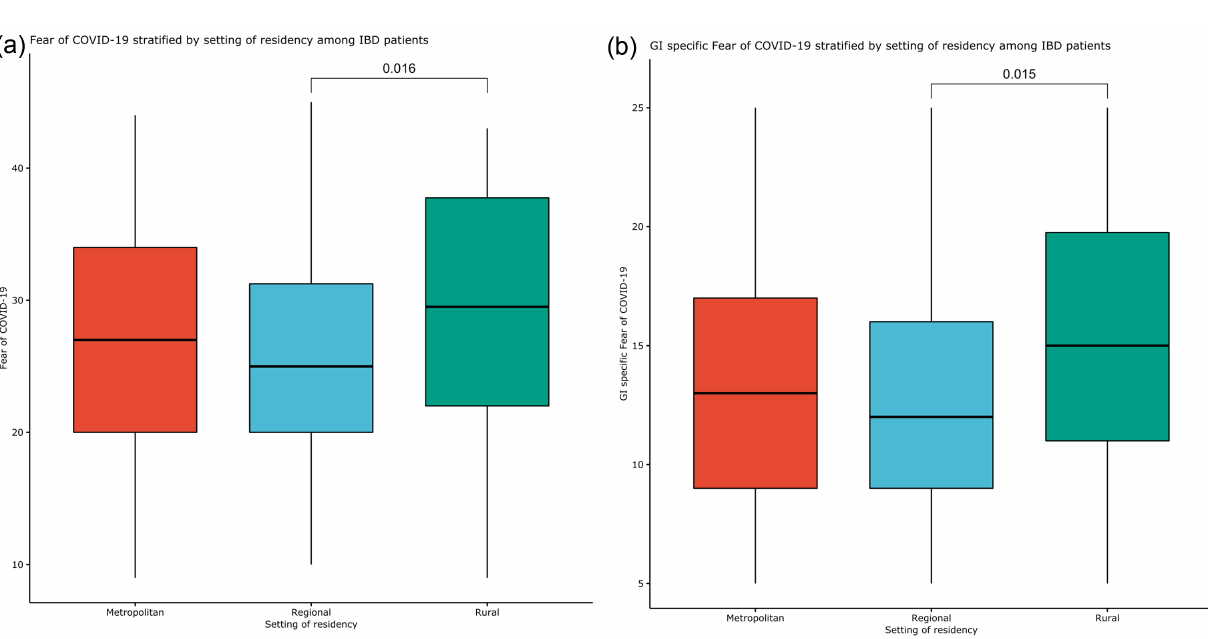
Figure 2. A-B. Fear of COVID-19 stratified by setting of residency among IBD patients (A) and GI-specific fear of COVID-19 stratified by setting of residency among IBD patients (B). IBD, inflammatory bowel disease; COVID-19, coronavirus disease 19; GI,